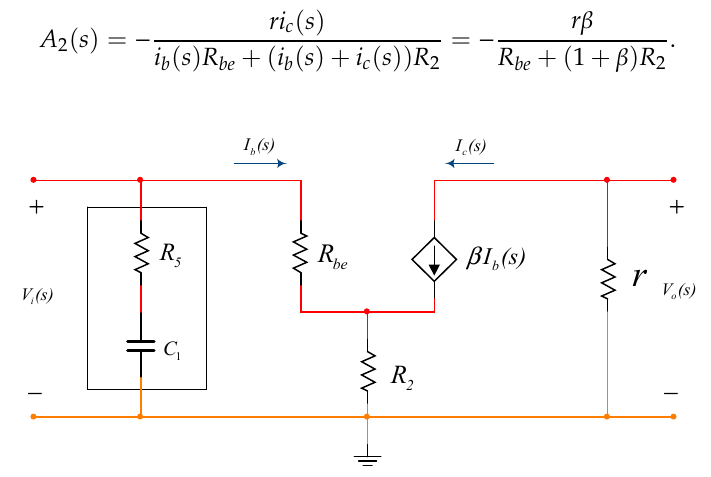
Figure 3. The equivalent circuit of the voltage-amplifying stage.